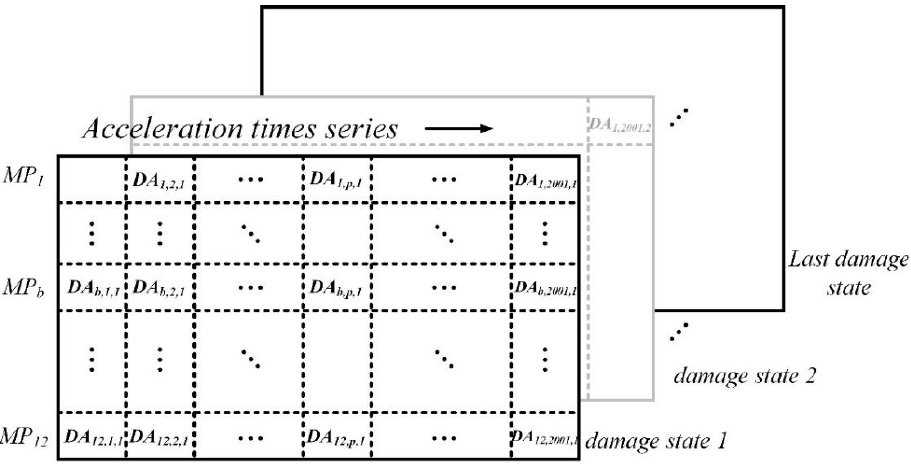
Figure 7. Input tensor structure for the PCG model.